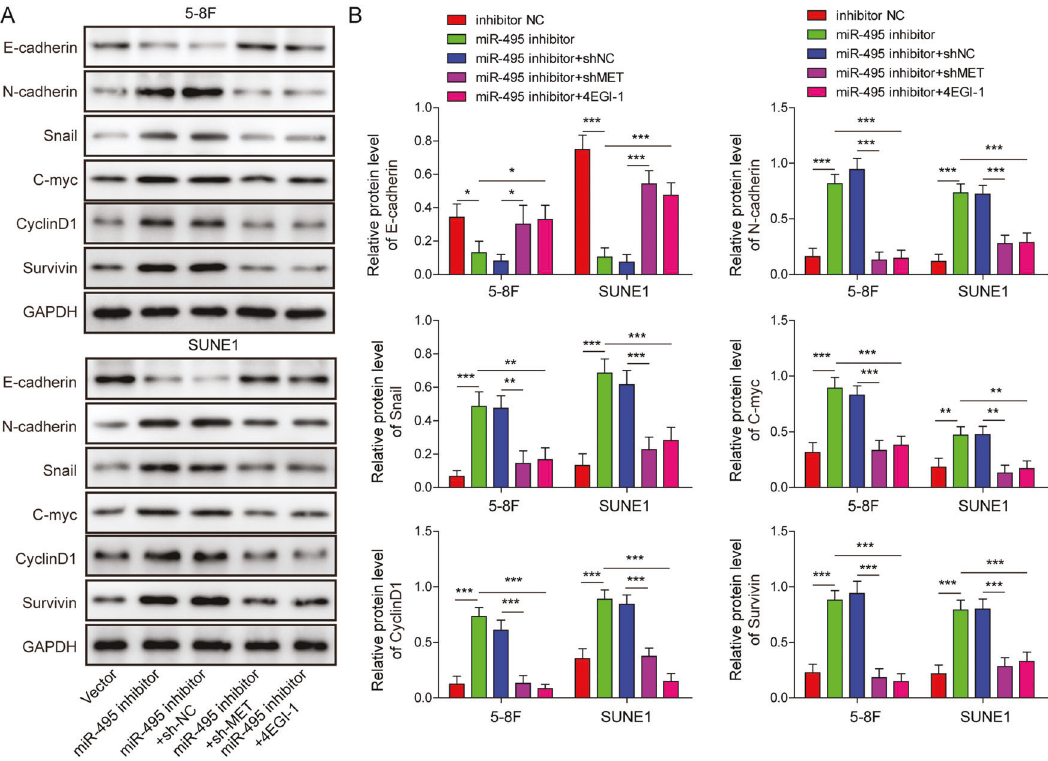
Fig. 7 miR-495 knockdown promoted EMT and cell proliferation-related signal by activating the MET-eIF4G1 translational regulation pathway. NPC cells were transfected with inhibitor NC, miR-495 inhibitor, miR-495 inhibitor + sh-NC, or miR-495 inhibitor + sh-MET respectively or treated with 4EGI-1 after miR-495 inhibitor transfection. A , B Western blotting analysis of E/N-cadherin, Snail, c-Myc, Cyclin D1 and Survivin in 5 – 8 F and SUNE1 cells. GAPDH was used as a loading control. * P < 0.05, ** P < 0.01 and *** P <